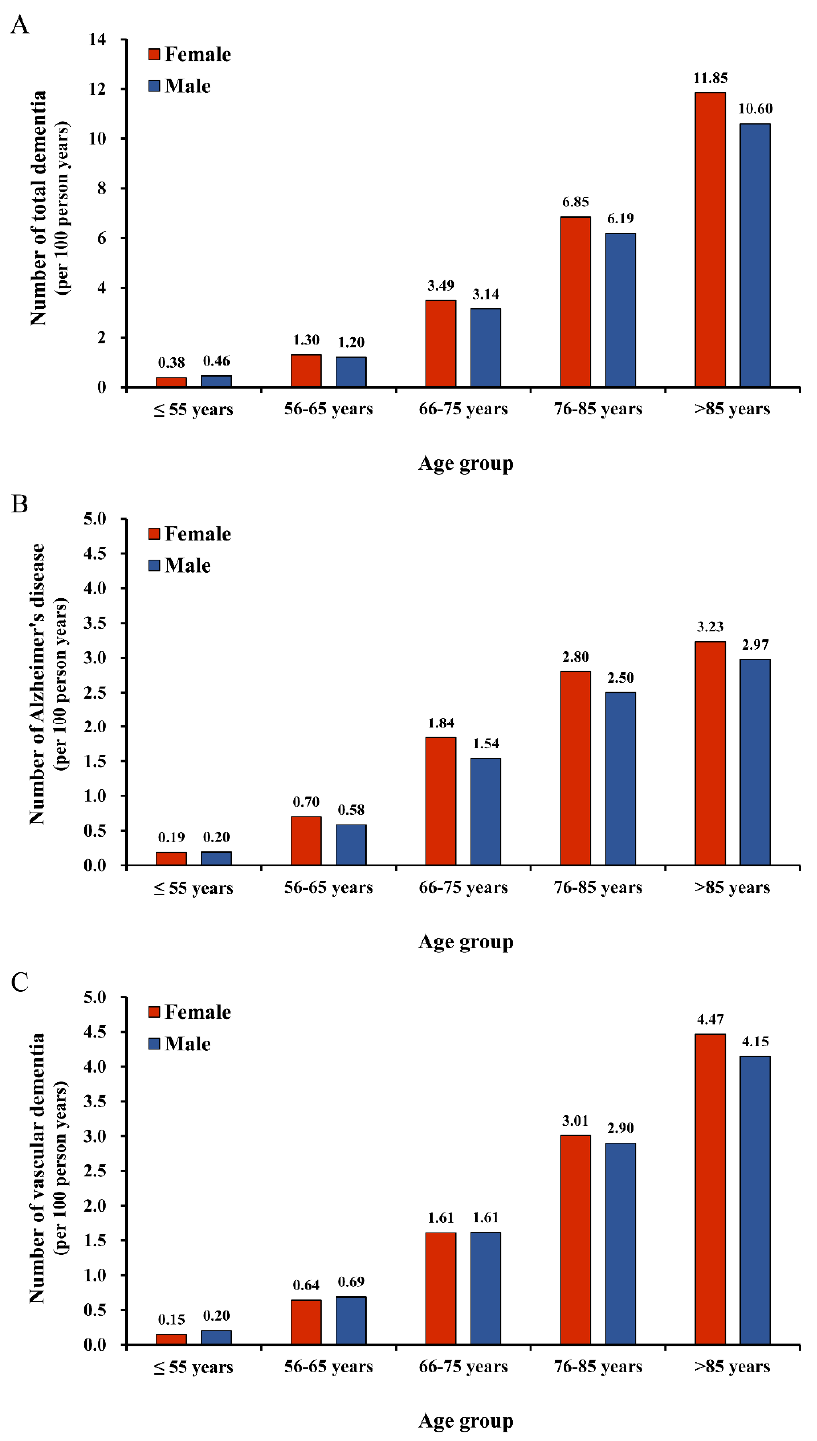
Figure 2. The incidence (expressed as the number of events per 100 person-years) of any dementia type ( A ), Alzheimer’s disease ( B ) and vascular dementia ( C ) in male and female patients with atrial fibrillation stratified by age distribution before propensity score matching.